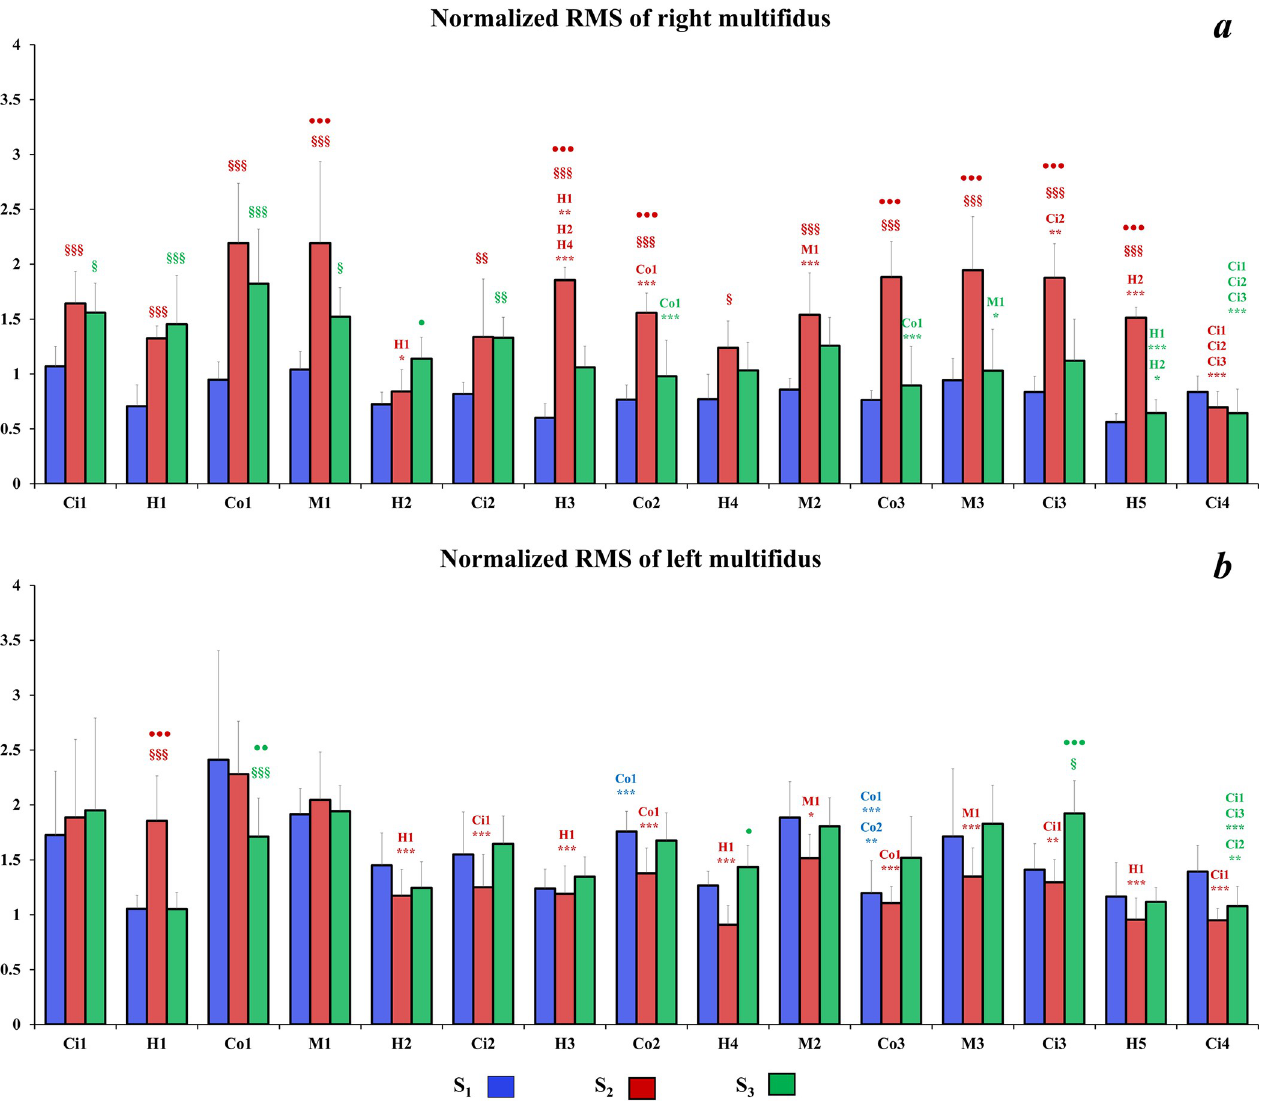
Fig 8. Mean of right (a) and left (b) MF normalized RMS values for each road sector for all seats. Significant differences between sectors of a same road type are symbolized by � (sectors concerned by the significant differences are mentioned above � ); significant differences between S 1 and other seats for a same road sector §; significant differences between S 2 and S 3 seats for a same road sector ●